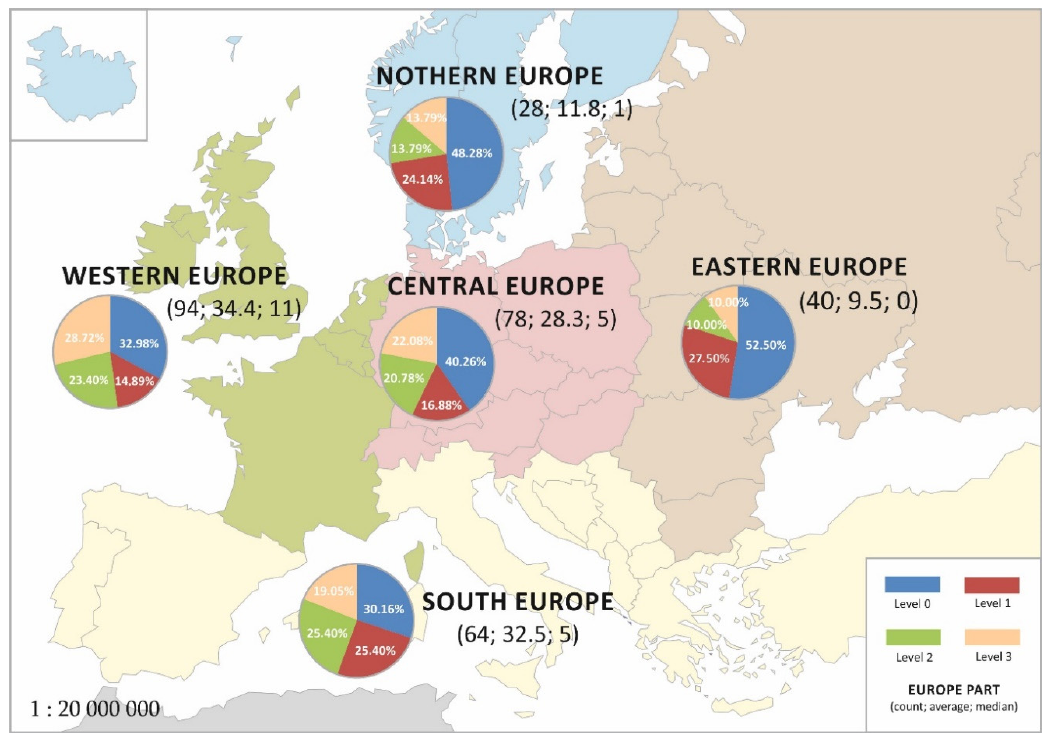
Figure 4. Results of statistical analysis for the number of partnerships in the studied promotional events, depending on the European region in which the event took place. Source: own study.